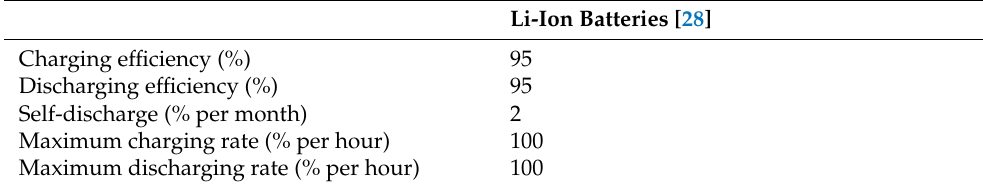
Li-Ion Batteries [28]